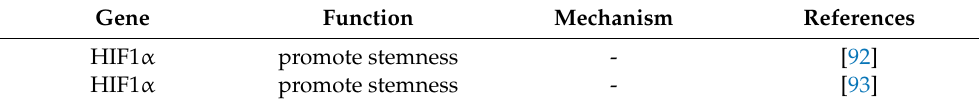
Table 6. HIF regulates gastric cancer progression by gastric cancer cell stemness.